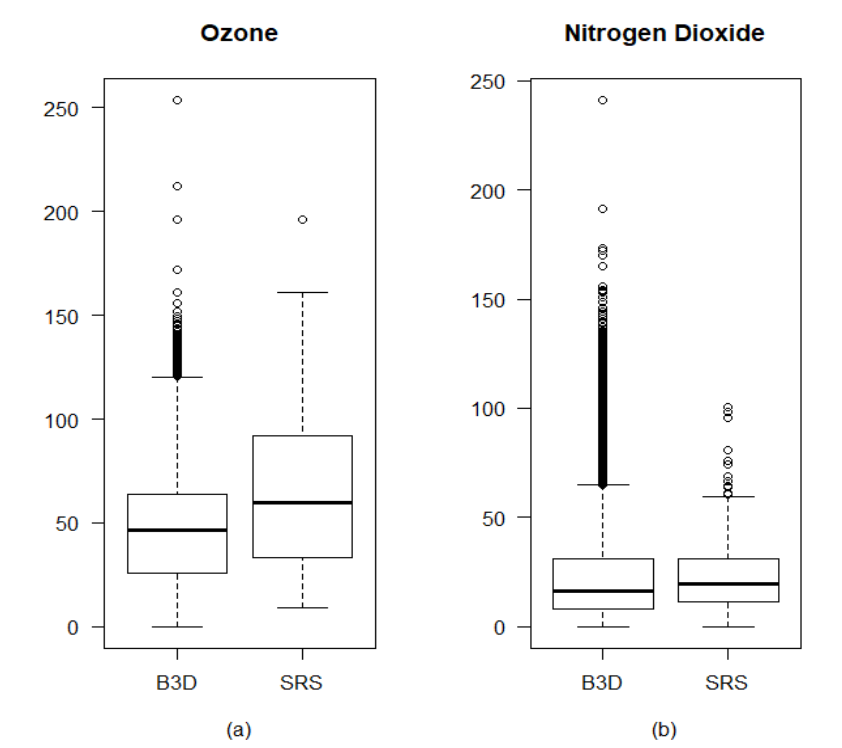
Figure 2. Boxplot of the four samples involved in the case study with air quality data. ( a ) Boxplot of the ozone level for the Big-But-Biased Data (B3D) sample (left) and the simple random sample (SRS) (right). ( b ) Boxplot of the nitrogen dioxide level for the B3D sample (left) and the SRS